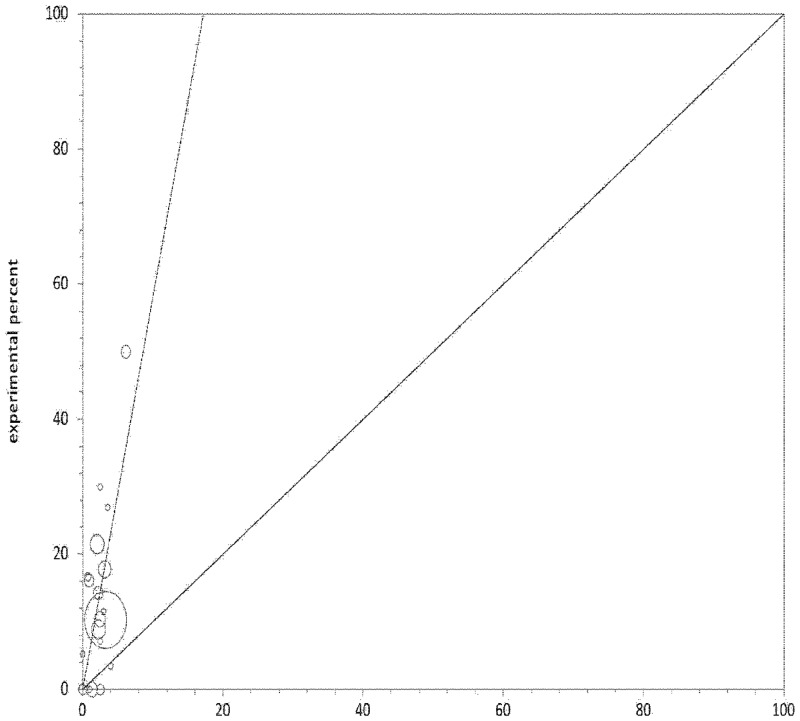
L’Abbé bias plot.